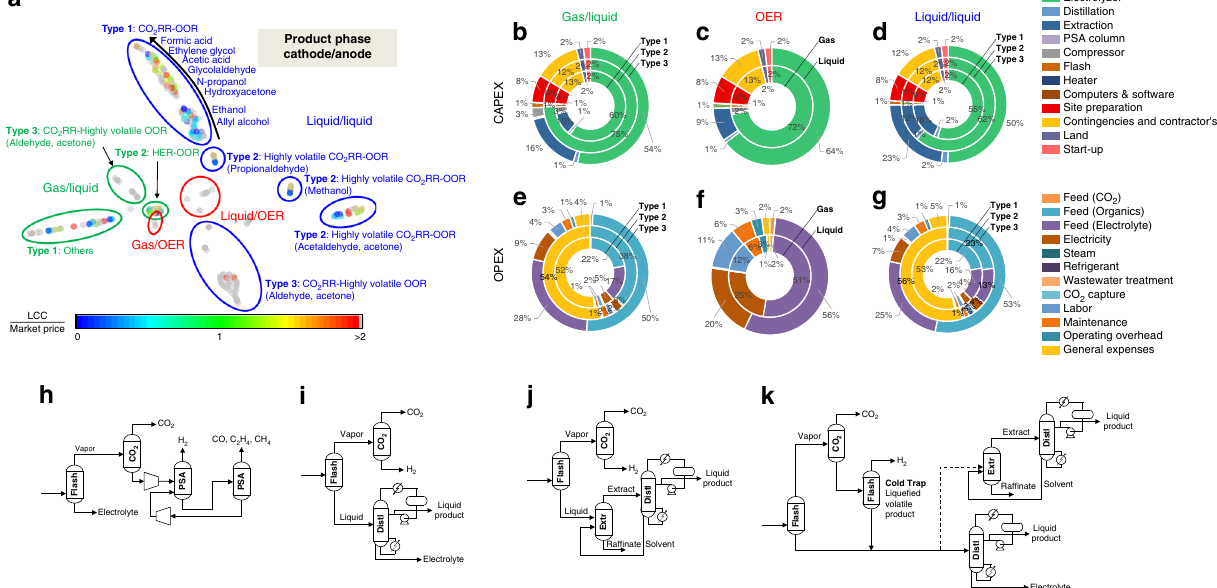
Fig. 5 All combinations of reduction reactions and oxidation reactions in the base case. a Two-dimensional latent space visualization of all the process designs using t-SNE 31 . Positions in the reduced latent space represent similarities in the process structure and mass balance. b – g Pie chart visualizing the level of contribution of each component in CAPEX and OPEX to various classes and types clustered in a . h and i Main structural differences in the separation processes for h gas products (cathode), i light liquid products, j heavy liquid or azeotrope products, and k highly volatile